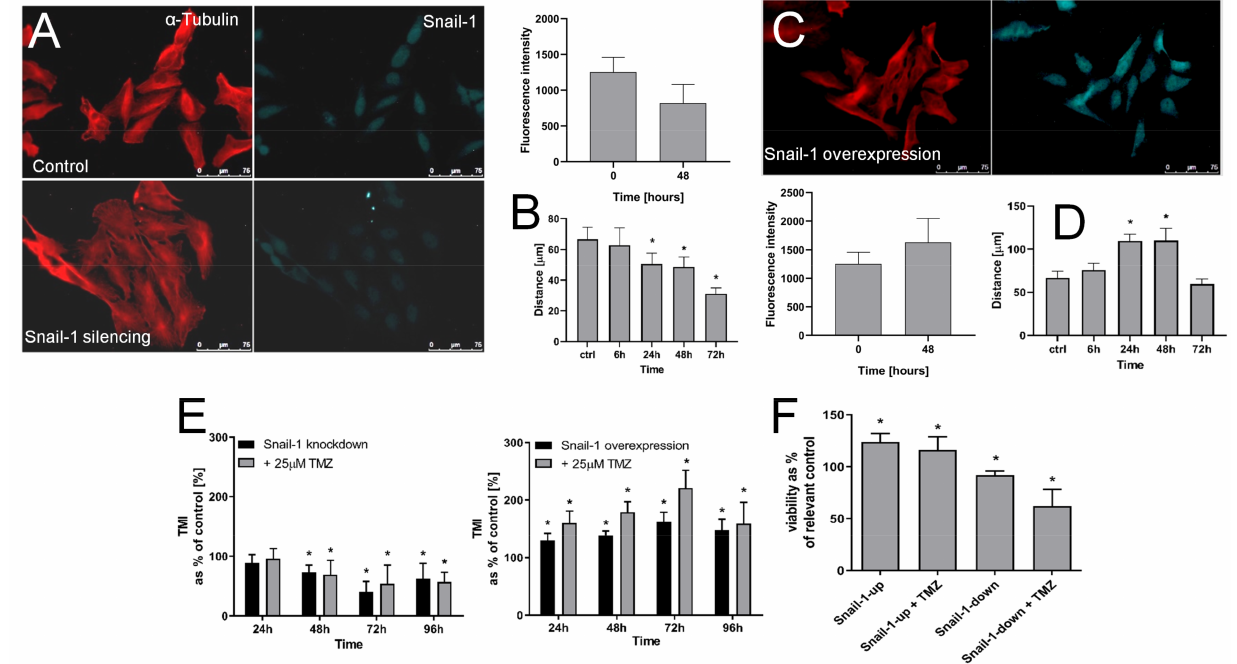
Figure 4. Effect of Snail-1 down/up-regulation on T98G phenotype. ( A ) T98G cells were transfected with Snail-1 targeting siRNA, followed by cytofluorimetric (FACS) estimation of intracellular Snail-1 levels and the analyses of cell morphology (right). Scale bar 75 µ m. ( B ) Time-lapse estimation of T98G motility estimated immediately 6, 24, 72 and 96 h after transfection. ( C , D ) T98G cells were transduced with Snai-1 expression vector. Their Snail-1 levels, morphology ( C ), and motility ( D ) was estimated as in ( A , B ). Scale bar 75 µ m. ( E , F ) The effect of 25 µ M TMZ on the transmigration efficiency (TransMigration Index; ( E )) and viability ( F ) of T98G cells undergone Snail-1 down/up-regulation. Statistical significance was calculated with ANOVA/non-parametric Mann–Whitney test, * p < 0.05 vs. control. Data are representative for three independent experiments. Note the synergy of Snail-1/TMZ effects on T98G